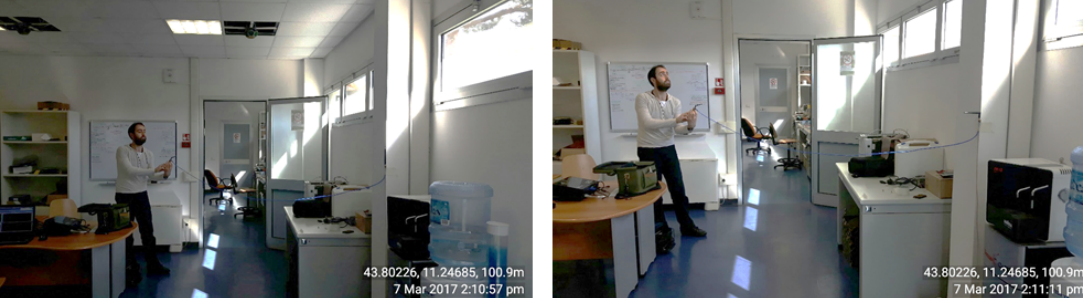
Figure 25. Experimental Session photo: LPv Case ( Left ) LPh Case ( Right ).